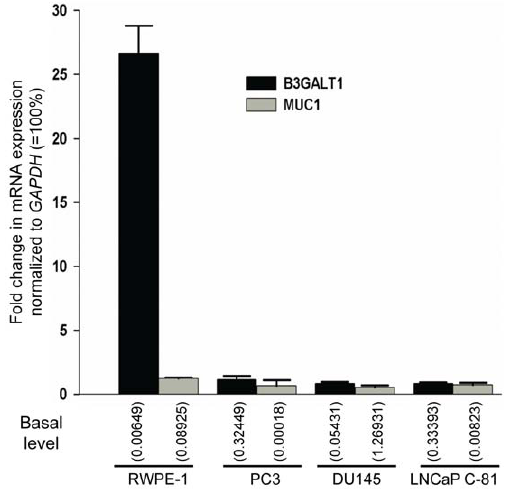
Figure 6. SAHA treatment stimulates the expression of B3GALT1 gene in RWPE-1 cells. Quantitative real-time PCR analysis was carried out on RWPE-1, PC3, DU145 and LNCaP C-81 cells treated with PBS or 5 m M SAHA for 72 h. Relative expression levels of B3GALT1 and MUC1 genes were sorted according to D Ct (see Materials and Methods) method, normalized with GAPDH in same cell preparation and expressed as fold changes 6 SEM determined by calculating the ratio of the expression level of each gene in SAHA-treated vs. that in PBS- treated control cells. Relative amount of each gene versus that of GAPDH (100%) in PBS-treated control cells was given in the parenthesis (n=3). The numbers shown in parenthesis represent % basal expression level relative to GAPDH (=100%).